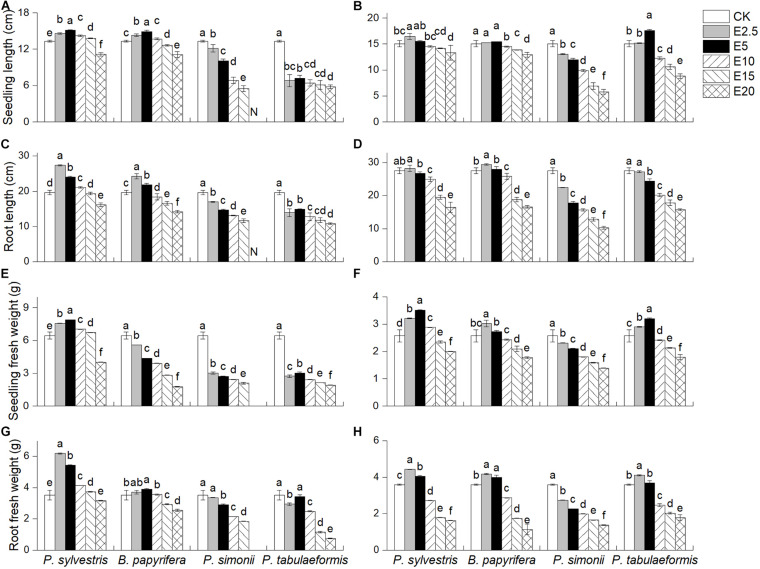
Effect of six different concentrations of aqueous leaf extracts [0% (CK), 2.5% (E2.5), 5% (E5), 10% (E10), 15% (E15), and 20% (E20)] collected from the donor species—P. sylvestris, B. papyrifera, P. simonii, and P. tabulaeformis—on (A,B) seedling length, (C,D) root length, (E,F) seedling fresh weight, and (G,H) root fresh weight of A. pedunculata (YC-1 and SC-6). “N” indicates that all plants had died; consequently, no relevant indicators were detected. Different letters in the same column indicate significant differences among different concentrations of aqueous leaf extracts from the same tree at the 0.05 level. Vertical bars represent standard deviation (n = 4).